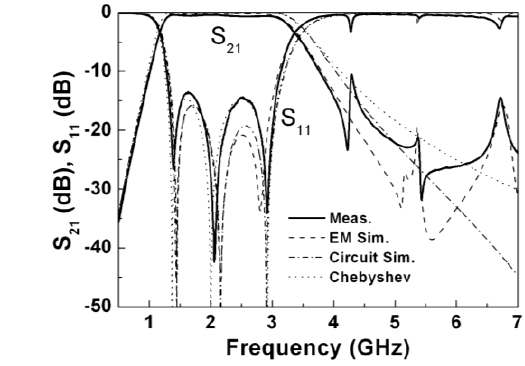
Figure 18. Fabricated wideband bandpass filter and frequency response. The substrate is the Rogers RO3010 with thickness h = 0.254 mm and measured dielectric constant  = 11.2. Dimensions are: l = 12.32 mm, W = 5.6 mm, G = 0.574 mm. For the OCSRR: r r =2.1 mm, c = 0.5 mm, d = 0.16 mm. For the OSRR: r = 1.9 mm, c = 0.3 mm, ext ext d = 0.16 mm. The element values of the circuit model are (in reference of Figure 13c and Figure 14c): C’ = 1.779 pF, L’ = 3.216 nH, C = 1.08 pF, L = 4.89 nH, L = 0.384 nH, p p s s C = 0.182 pF and L = 0.2 nH, where an additional shunt inductance L in series with the hs hs OCSRR tank has been considered to take into account the shunt inductive effect of the narrow strip connection between the main line and the OCSRR (this being needed to predict the broadband response of the OCSRR). From [44]; copyright  2011, Elsevier; reprinted with